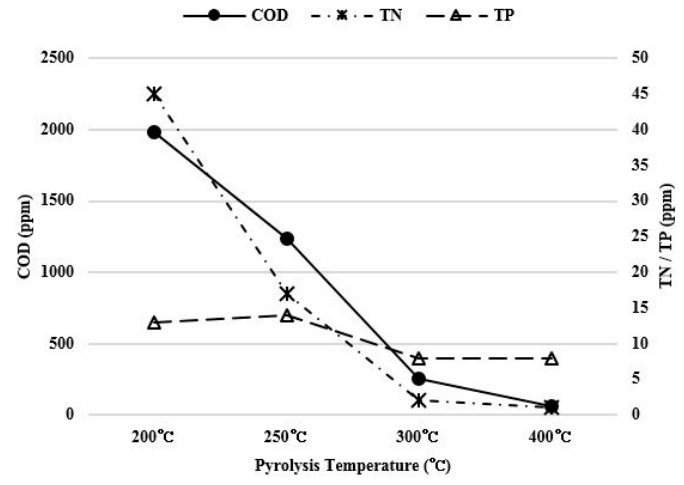
Figure 7. Pollution level of washing water for each pyrolysis temperature.